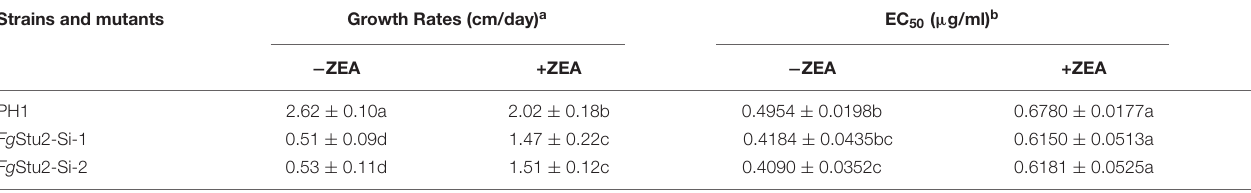
TABLE 2 | Hyphal growth rate and sensitivity of wild-type strain PH1, Fg Stu2 promoter replacement mutants to MBC on PDA with or without 30 µ M zearalenone (ZEA). Strains and mutants Growth Rates (cm/day) a